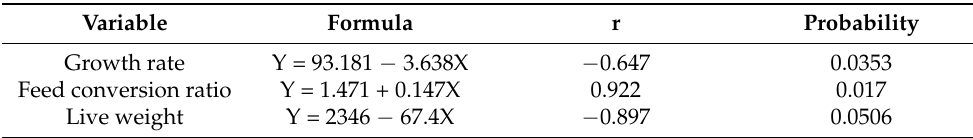
Table 8. The relationships between the dietary crude fiber level (%) and production performance of the male Ross 308 broiler chickens aged 22 to 42